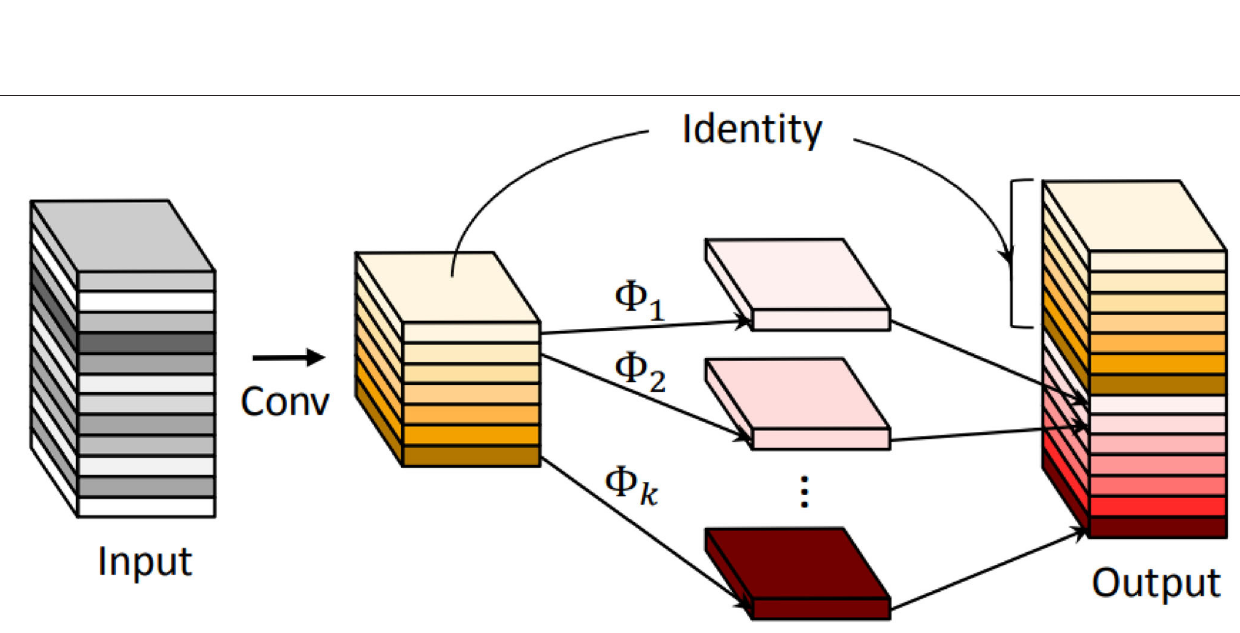
Frontiers in Neuroinformatics | www.frontiersin.org 5 June 2022 | Volume 16 | Article